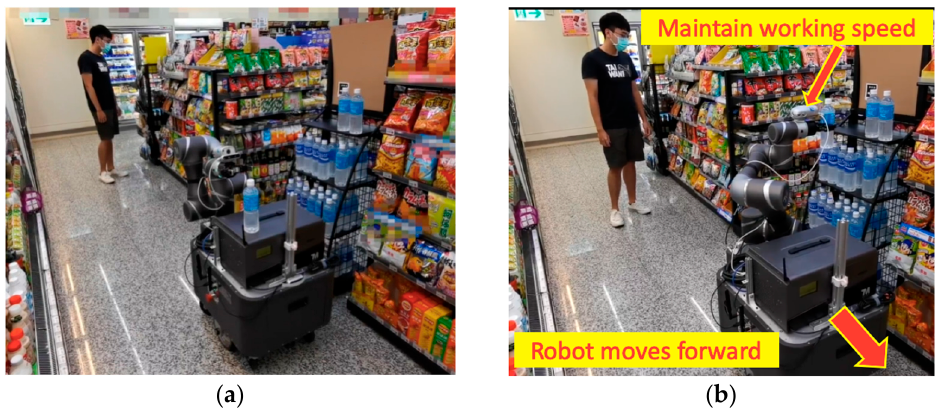
Figure 14. ( a ) The customer approached the robot and ( b ) the mobile platform moved forward.